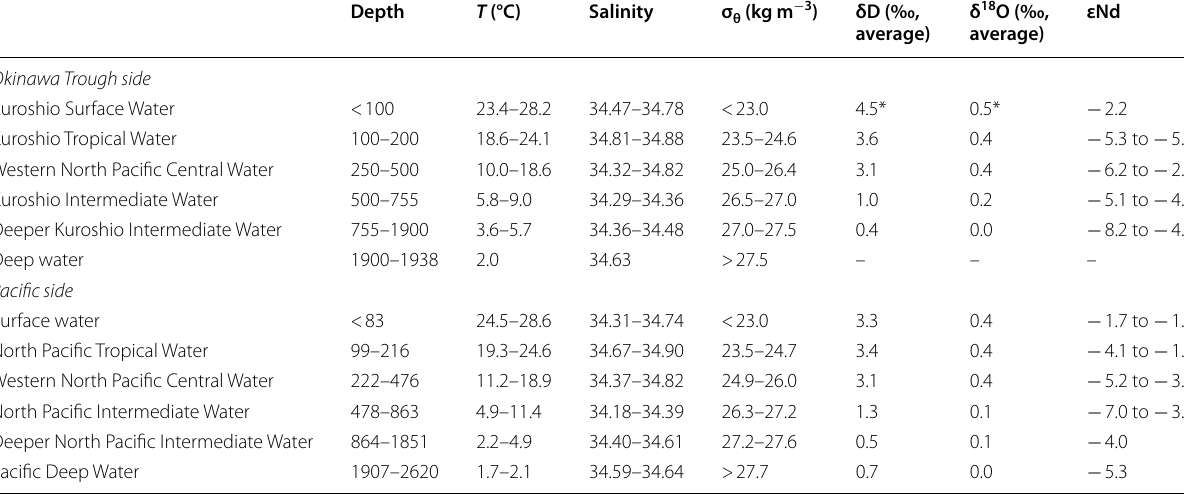
Table 1 Characterization of the water masses in the southern Ryukyu Island Arc. *Only one data available